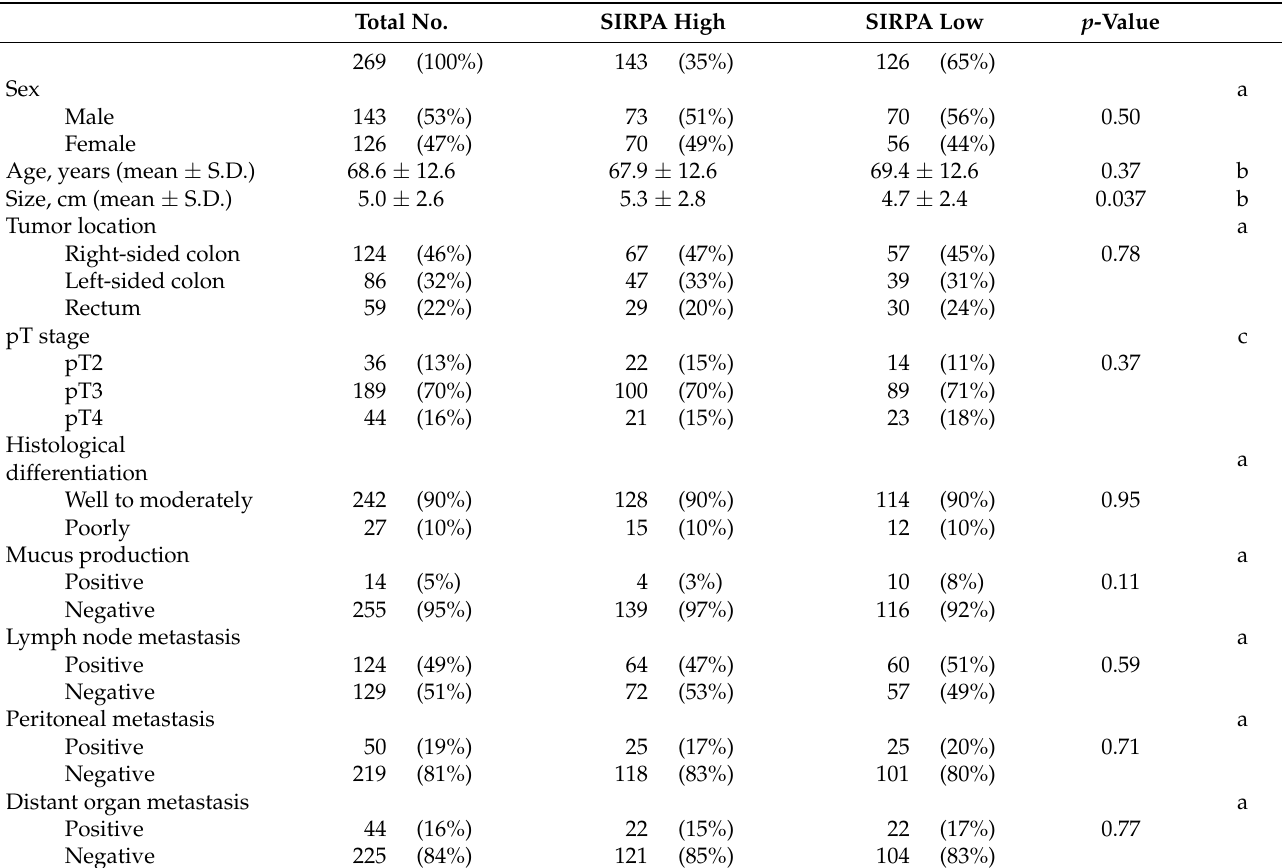
Table 2. Characteristics of colorectal carcinomas with high or low SIRPA expression. a, p -values were calculated by the Chi-square test for CD47 expression. b, t -test or c, Cochran–Armitage trend test was used to calculate p -values. The Bonferroni-corrected p -value for significance was p ≈ 0.0042